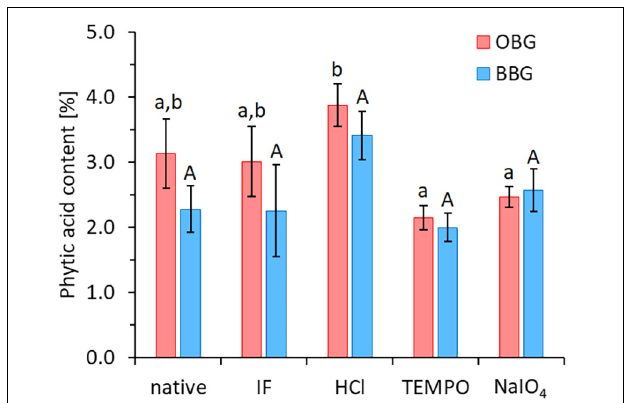
FIGURE 6 | Phytic acid contents of the native and Chelex-treated (“iron-free”, IF) oat (OBG) and barley (BBG) β -glucan extracts, as well as the three modifications (HCl, TEMPO, NaIO 4 ) that used OBG/BBG IF as starting material. Different lowercase and uppercase letters indicate statistically significant differences within oat and barley samples, respectively ( p < 0.05). There were no significant differences between oat and barley pairs for each treatment type ( p >